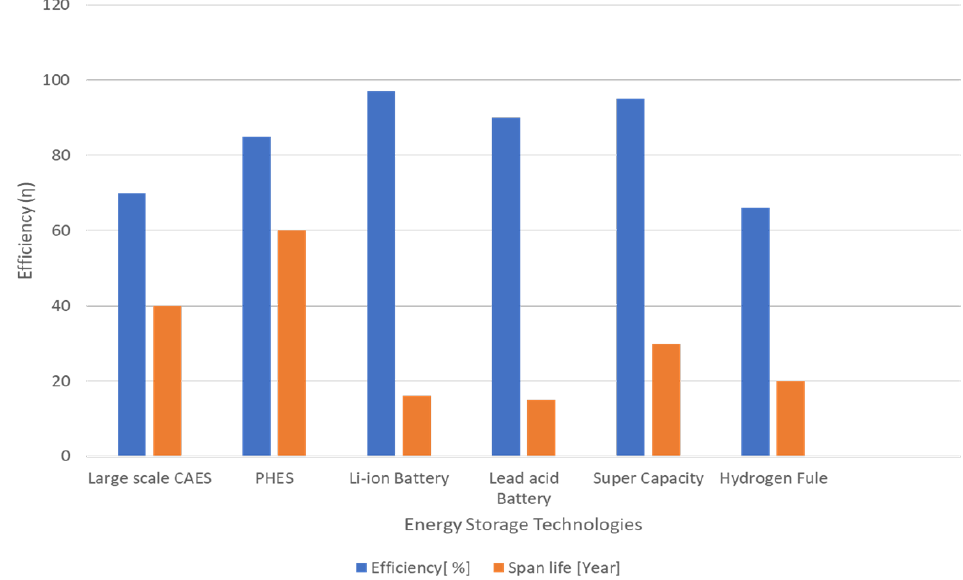
Figure 1. The main characteristics of energy storage technologies.